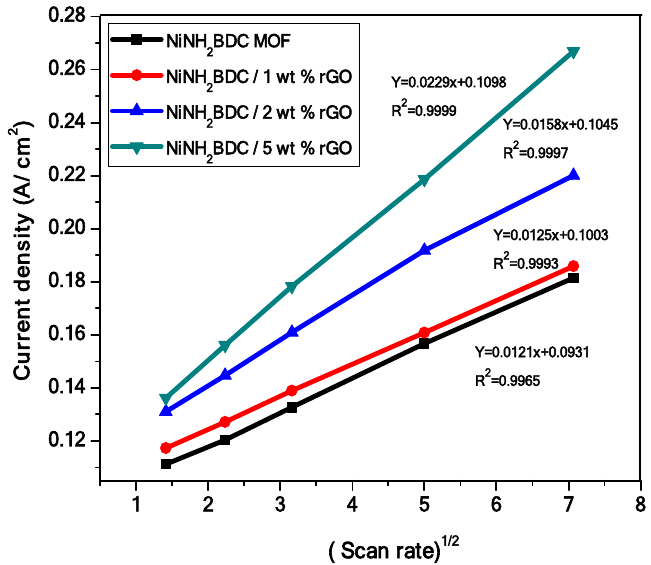
Figure 9. A graphical representation of the direct relationship of peak current density (j) versus under root of scan rate (ν) in 3 M CH 3 OH/1 M NaOH solution.